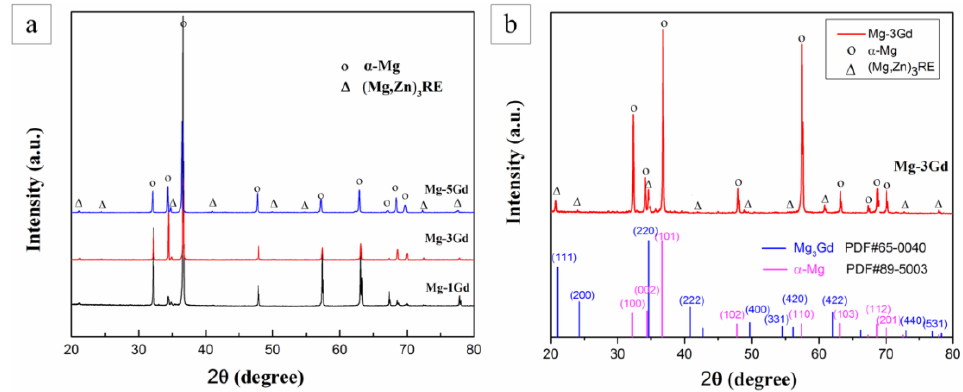
Figure 3. The X-ray Diffraction (XRD) pattern of the as-cast Mg-xGd alloys ( a ), phase comparison and corresponding ICCD cards ( b ).